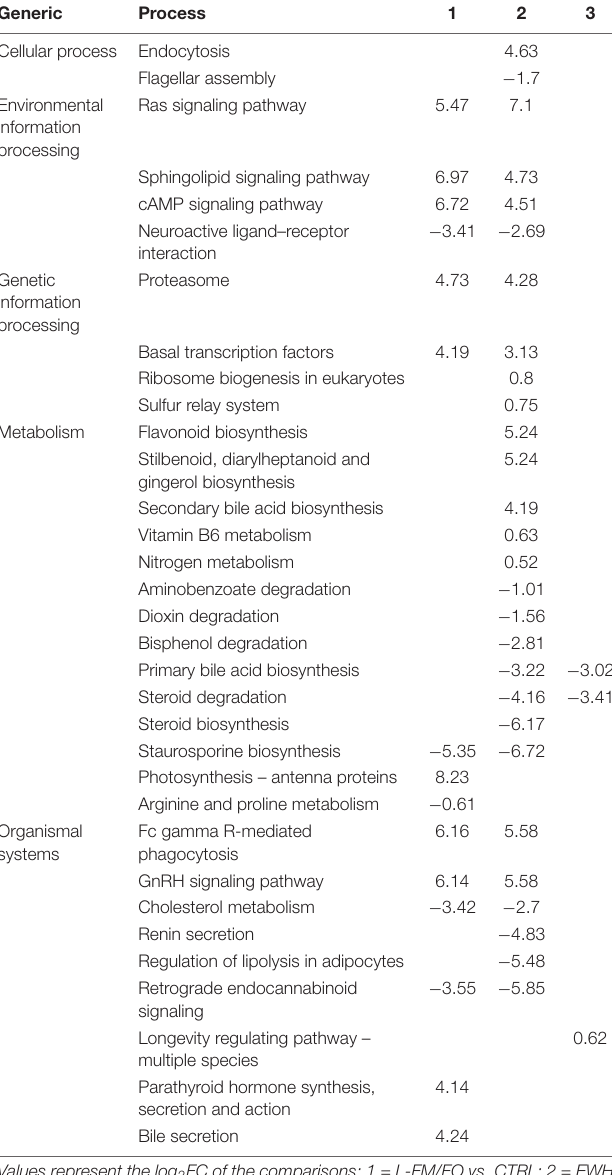
TABLE 4 | Pathway analysis from predicted